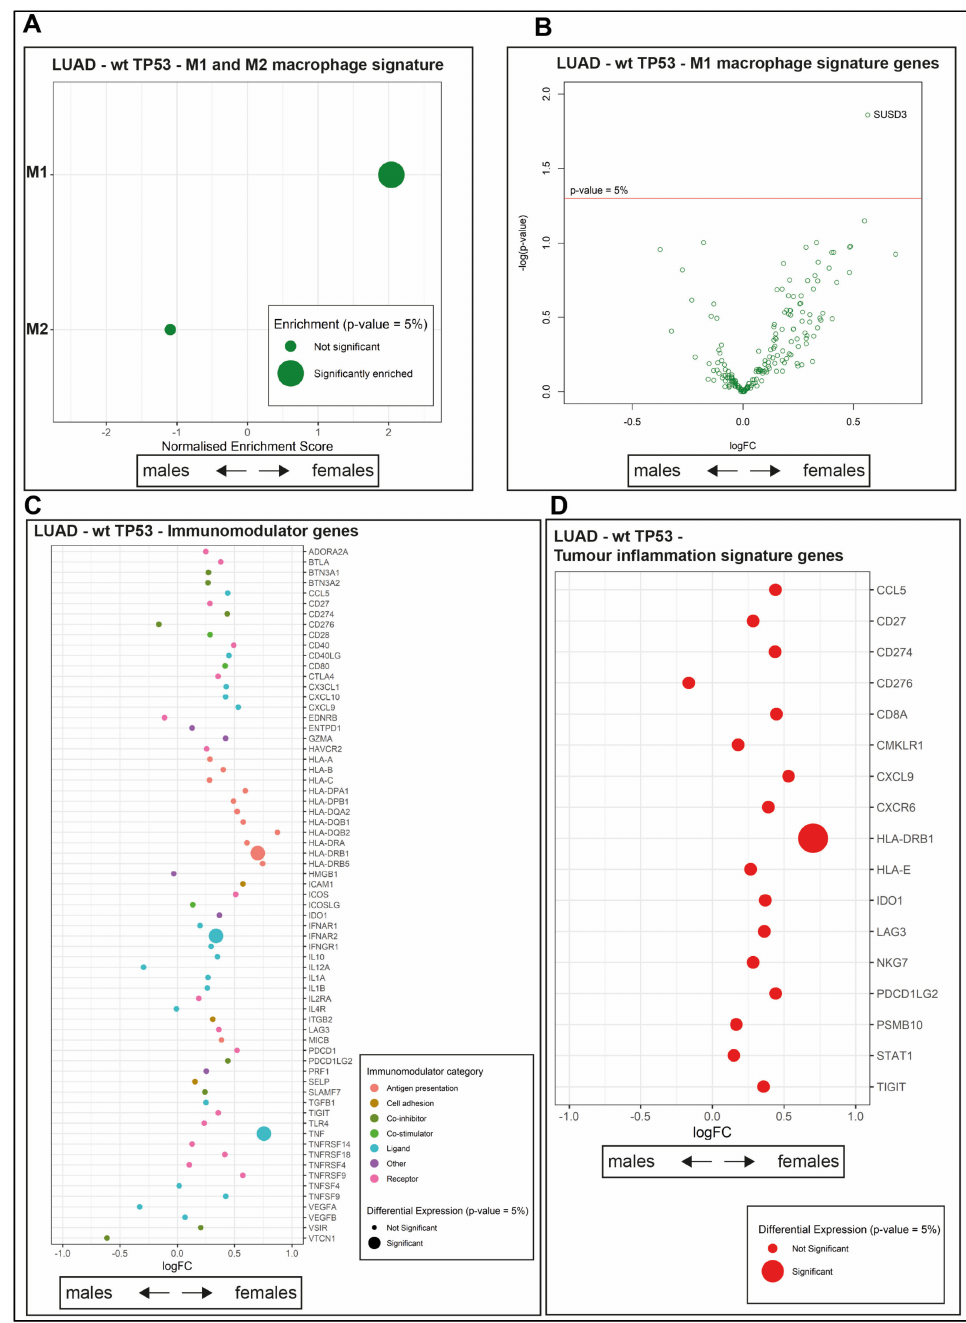
Figure 3. Sex-disparity in expression of immune genes in wt TP53 LUAD. Comparison of immune infiltrate genes expression between LUAD wt TP53 females and LUAD wt males using ( A ) GSEA of M1 and M2 macrophage genes, ( B ) di ff erential gene expression analysis of M1 macrophage genes (with gene name assignment for p -values < 0.05), ( C ) di ff erential gene expression of immunomodulator signatures, and ( D ) di ff erential gene expression of tumor inflammation signature (TIS) genes. For panels A , C and D ; significantly enriched immune signatures / genes (p- value < 0.05) are denoted by a large dot, respectively. A positive log fold change (logFC) demarks higher di ff erential gene expression in females, while negative values indicate higher levels in